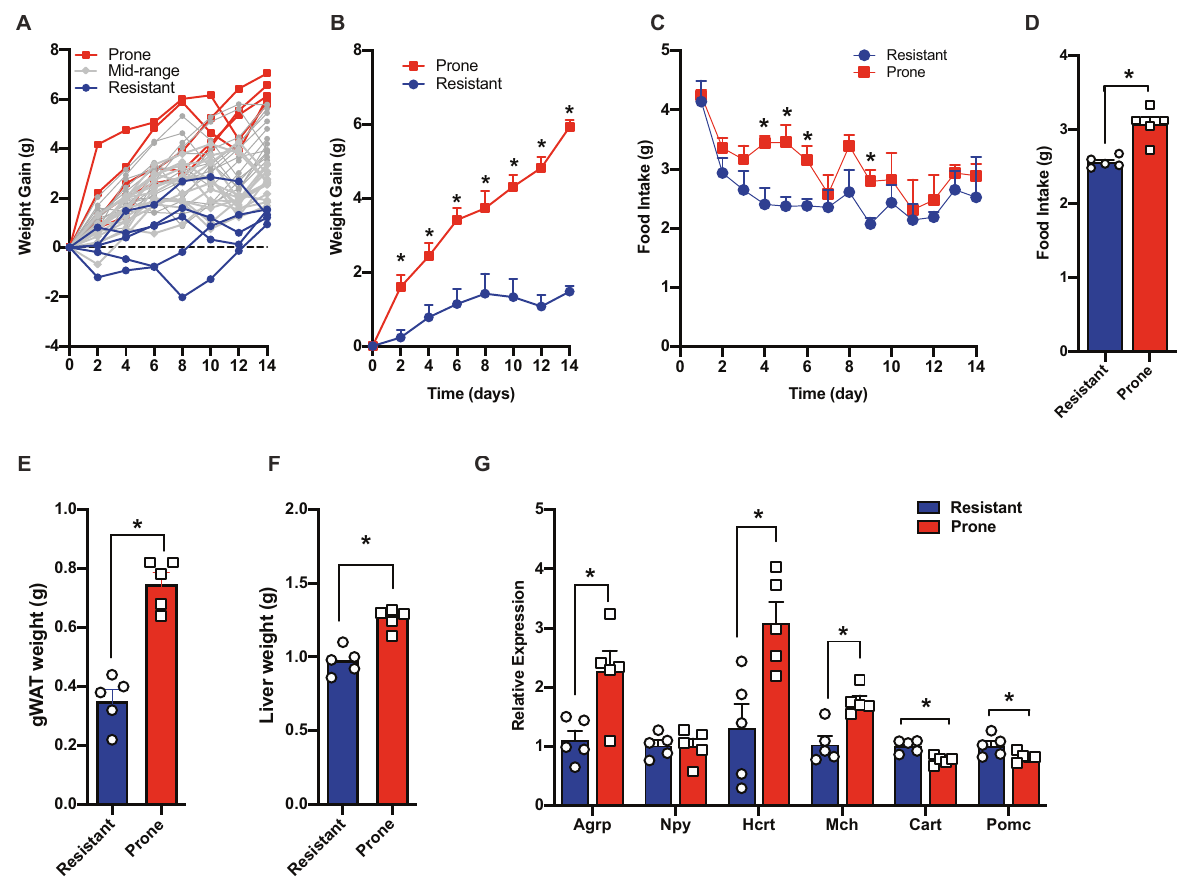
Fig. 1 Weight gain and food intake in response to olanzapine treatment. A . Individual daily weight gain in all 40 mice. B Average weight gain. C Average daily food intake. D Average food intake across 14 days of treatment. E gWAT. F Liver weight. G Hypothalamic gene expression in top fi ve most weight gain ‘ prone ’ mice and fi ve most ‘ resistant ’ to weight gain. * p < 0.05 determined by students t -test and corrected with 2-stage set- up method of Banjamini Krieger and Yekutieli for multiple comparisons with FDR = 0.10. Data are expressed as mean ± standard